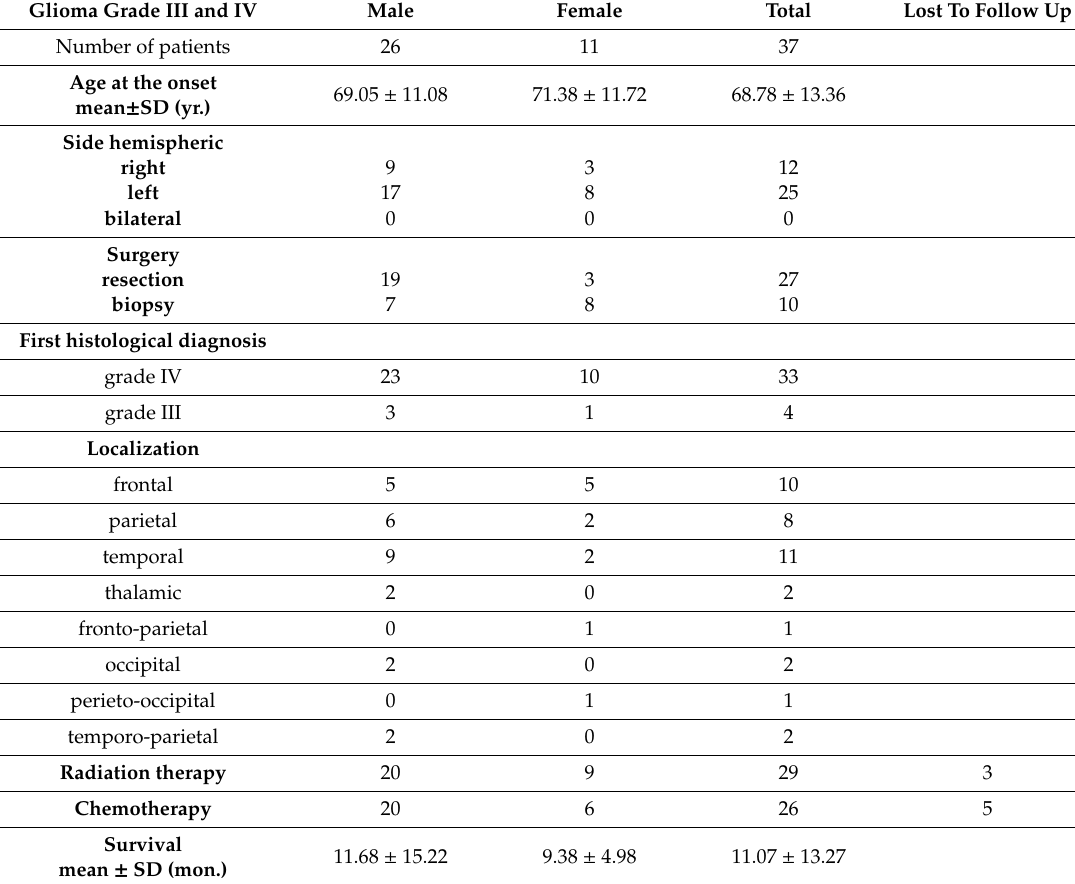
Table 1. Patients with glioma grade III and IV at the study center Idar-Oberstein, Germany were included. Patient characteristics (gender, age), as well as primary tumor data including localization, therapy, and follow-up are